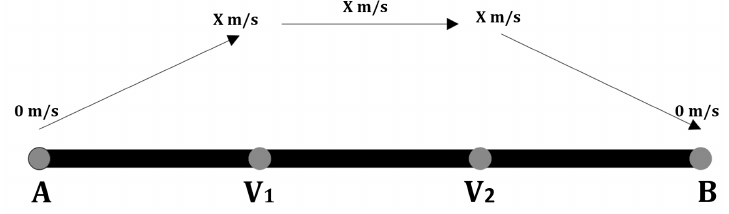
Figure 20. UAV horizontal speed variation while covering track